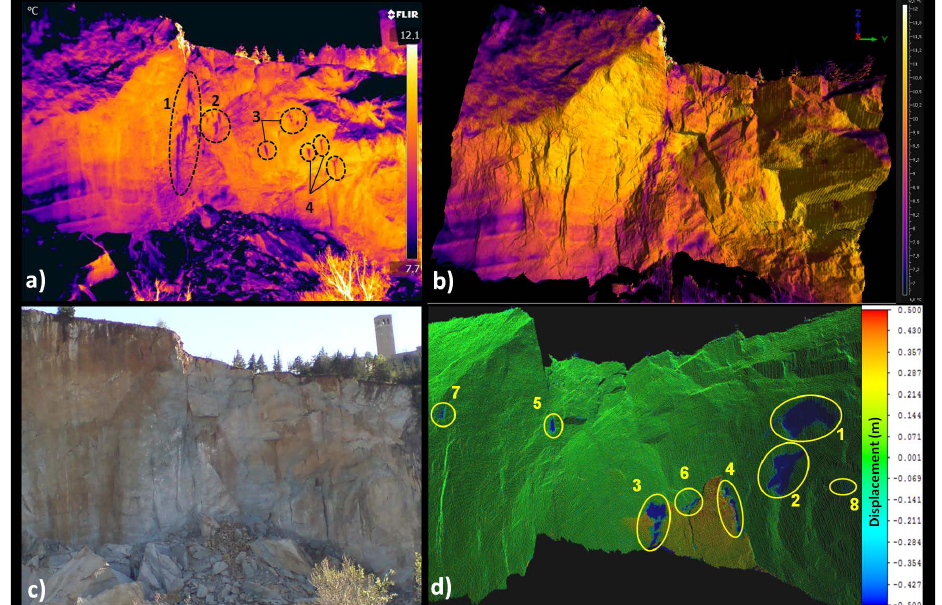
Figure 11. Thermogram of the San Leo rock cliff acquired on 9 April 2014 ( a ), with corresponding optical image ( b ). Obtained 3D surface temperature map ( c ) (seepage sectors 1–4 are highlighted by black dashed ovals). Comparison between 7 March 2014 and 18 December TLS scans ( d ), locating the occurring detached rock block sectors (in yellow) and rock wall sector characterized by toppling phenomena (orange-yellow areas), after